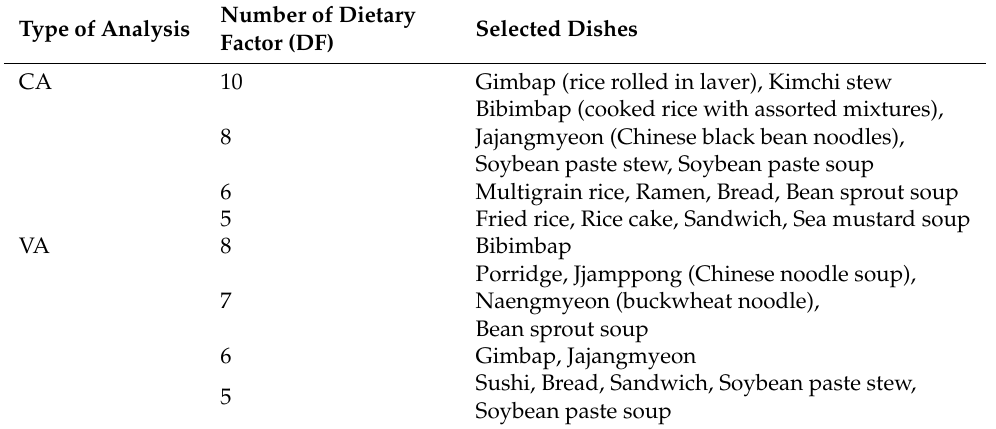
Table 1. Selected dishes from both the contribution analysis (CA) and variability analysis (VA) for the highest number of cancer- and non-cancer-related dietary